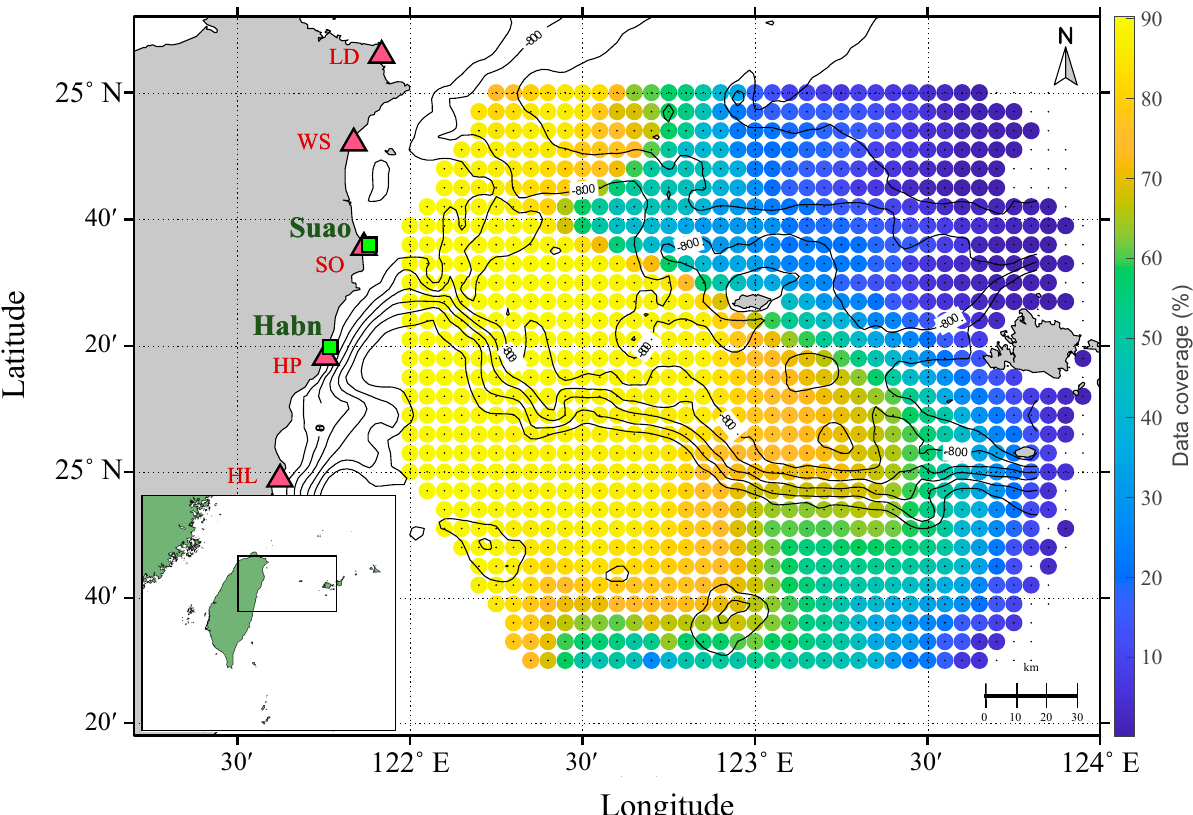
Figure 1. The surface current data coverage in percentages (%) in 2013. Green squares indicate the Suao and Habn HFR stations. The red triangles indicate the tide-gauge stations along the coastline. The island in the center and the island closest to the eastern edge of the domain are the Japanese islands of Yonaguni and Iriomote, respectively. The black box inside the inset at the bottom left represents the study area.